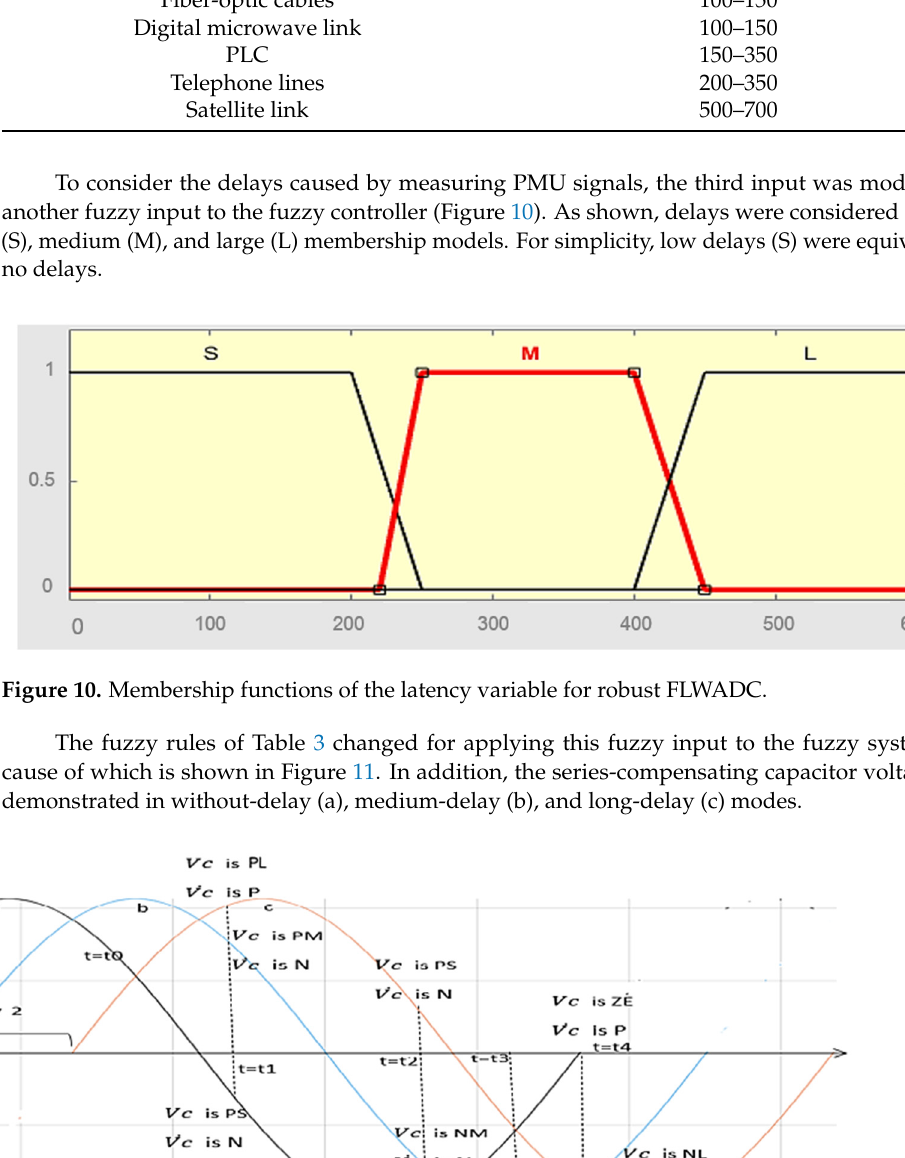
Table 5. Time delay in various communication links [31].